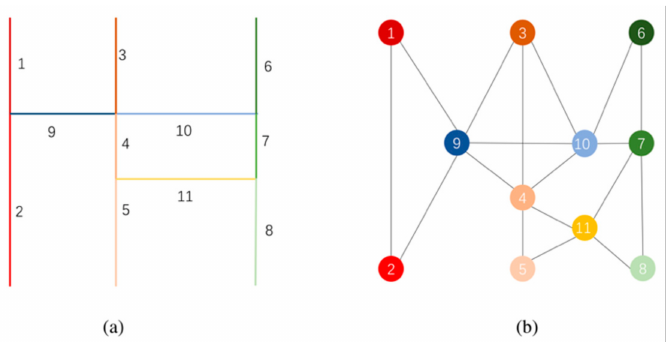
Figure 3. Road network ( a ) abstracted as an undirected unweighted dual graph ( b